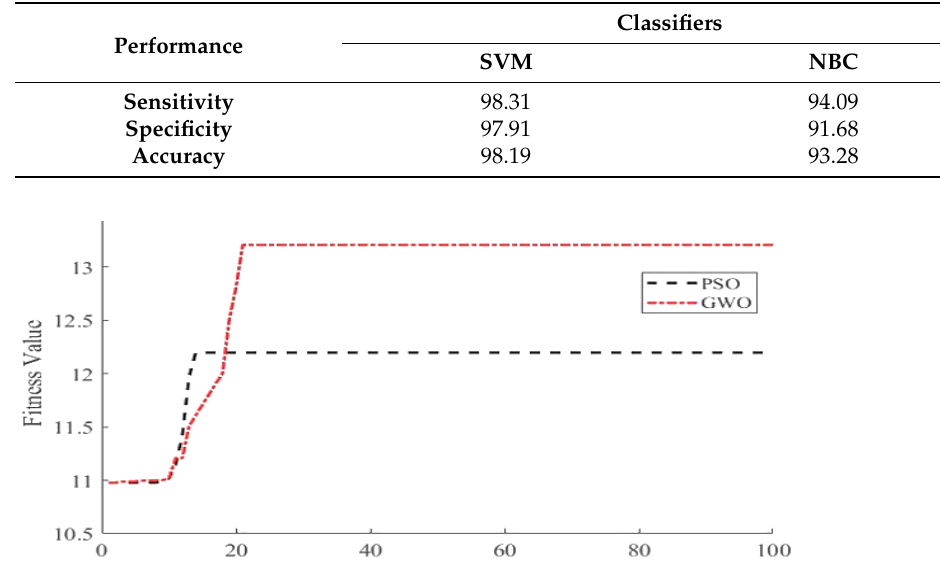
Figure 6. Convergence comparison between PSO and GWO.